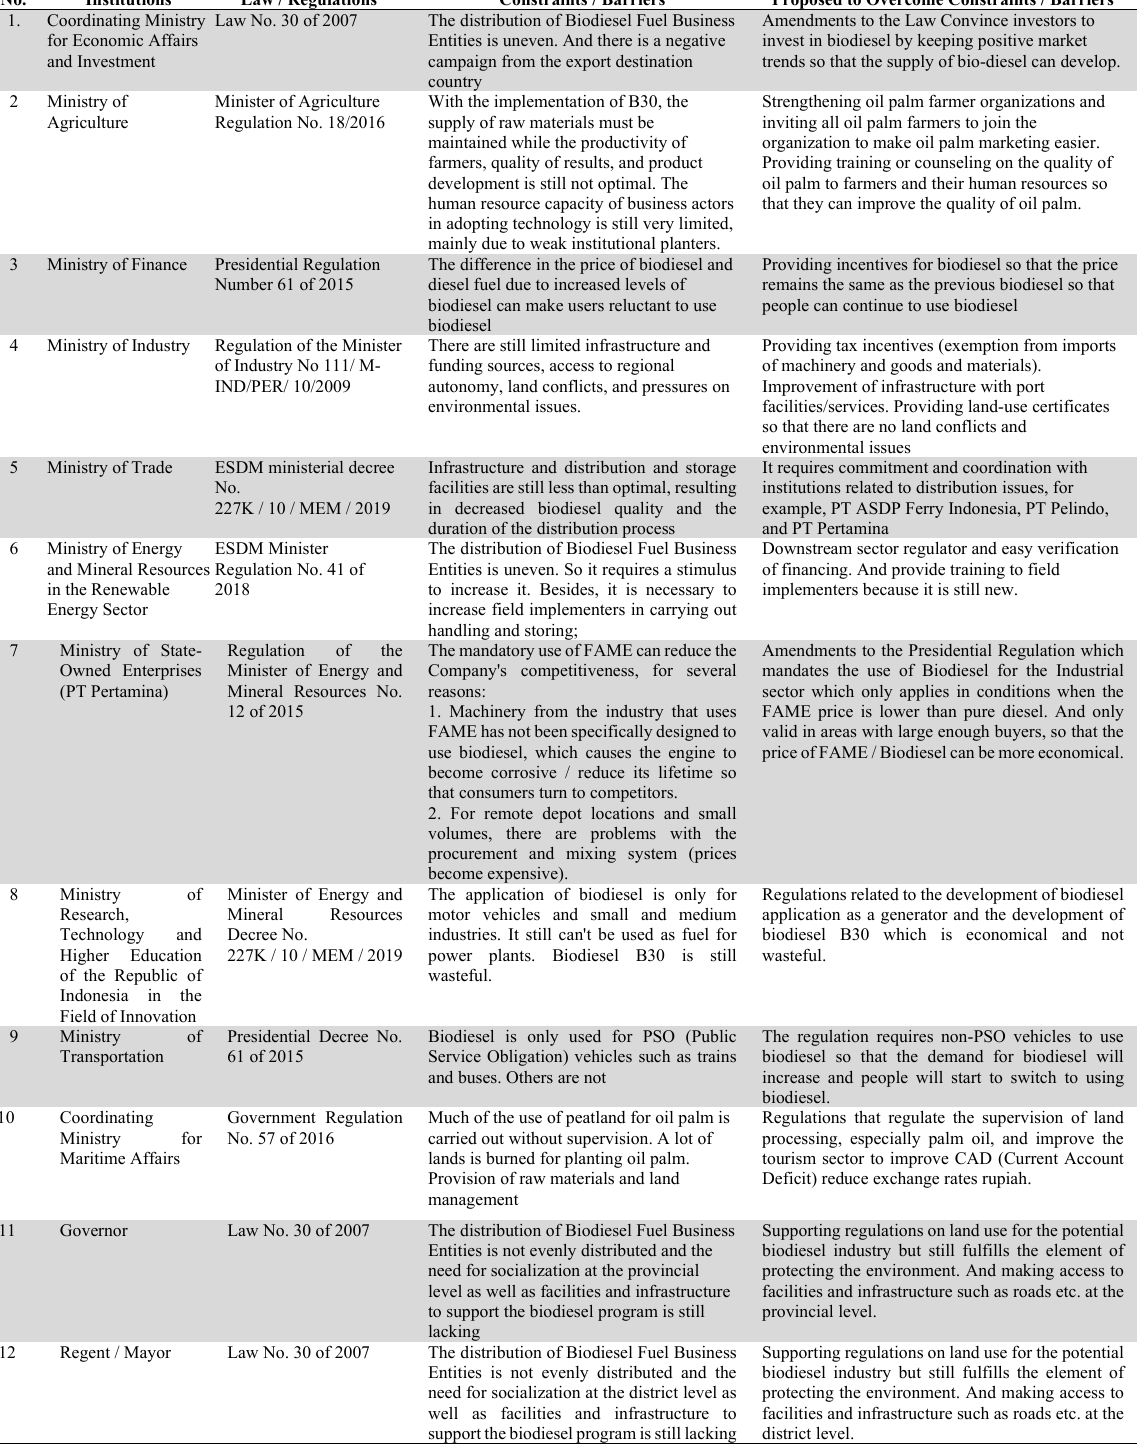
Draft Omnibus Law Material from Sectoral Regulations / Regulations To Support Biodiesel